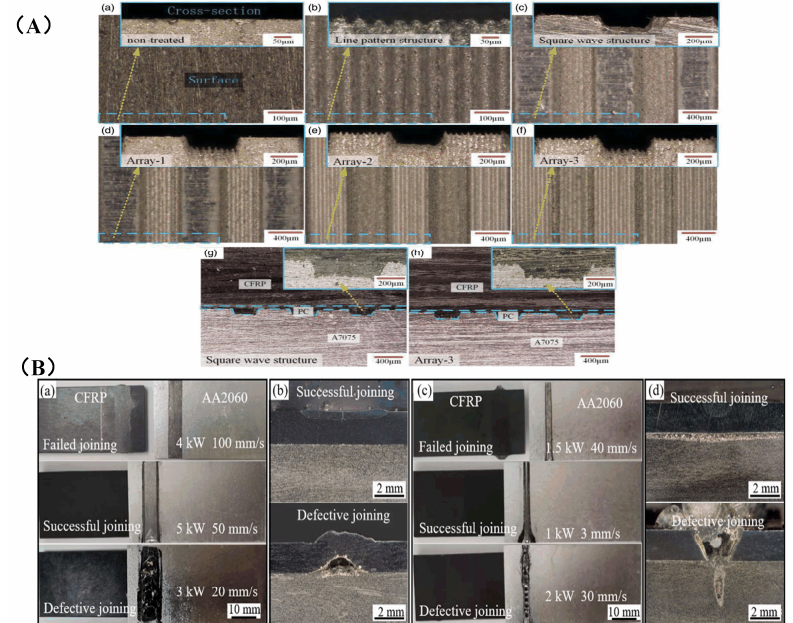
Figure 18. Cross-sectional and surface pictures produced by laser processing: ( A ) ( a – f ) six different scan arrays; ( g , h ) cross-sectional images of Al-PCCFRP adhesion lap-joint samples with interfacial microstructures: the square wave structure and array 3 [126]; ( B ) typical surface and cross-sectional morphology of CFRP/AA2060 joints: ( a , b ) rectangular and ( c , d ) circular spots [131].